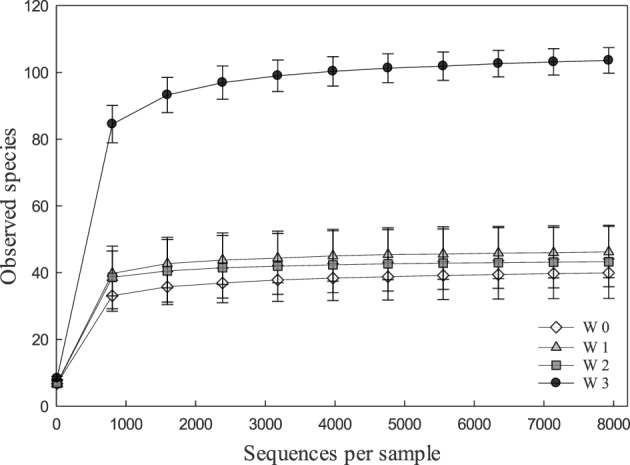
Rarefaction curves indicating the effect of the number of partial sequences of 16S rRNA genes that were analyzed on the number of OUT's in fecal microbiota of pigs. Rarefaction curves were calculated in QIIME with the sample depth of 7939 sequences per sample from 137 fecal samples obtained at weaning (week 0, n = 29), or at week 1 (n = 36), week 2 (n = 36), and week 3 (n = 36) after weaning.